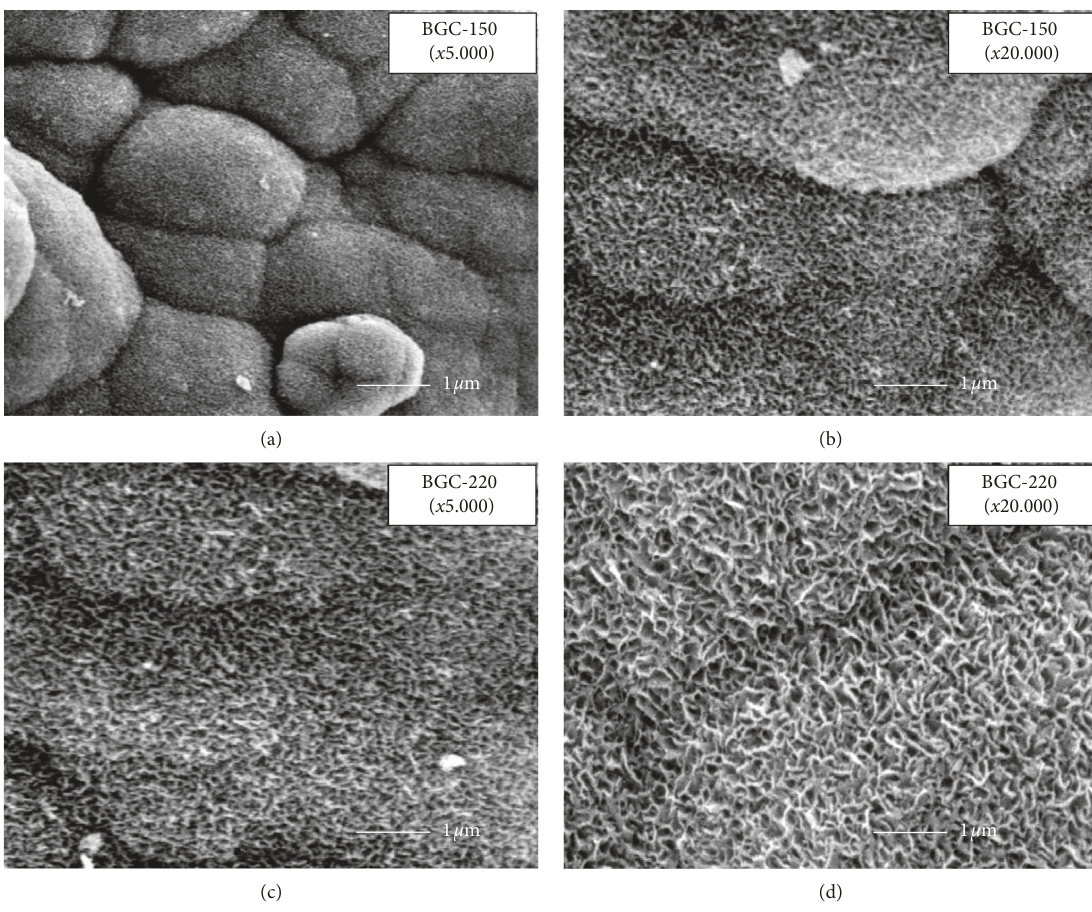
Figure 7: SEM micrographs of BGC-150 and BGC-220 at different magnifications after 20 days of immersion.